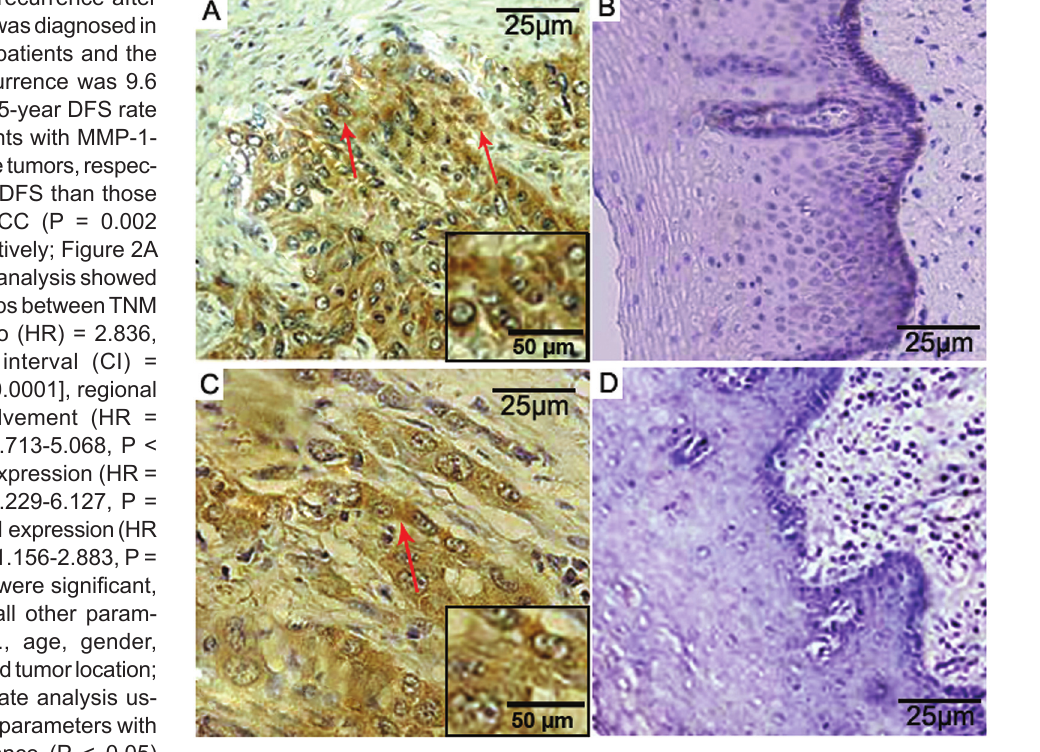
Figure 1. Matrix metalloprotease-1 (MMP-1) and protease-activated receptor-1 (PAR-1) ex- pression determined by immunohistochemical staining. A , Representative MMP-1-positive esophageal squamous cell carcinoma showing staining mainly on the cell membranes and/ or in the cytoplasm of tumor cells (arrows); B , representative normal squamous epithelium negative for MMP-1 expression; C , representative PAR-1-positive esophageal squamous cell carcinoma showing staining mainly in the cytoplasm of tumor cells (arrow); D , represen- tative normal squamous epithelium negative for PAR-1